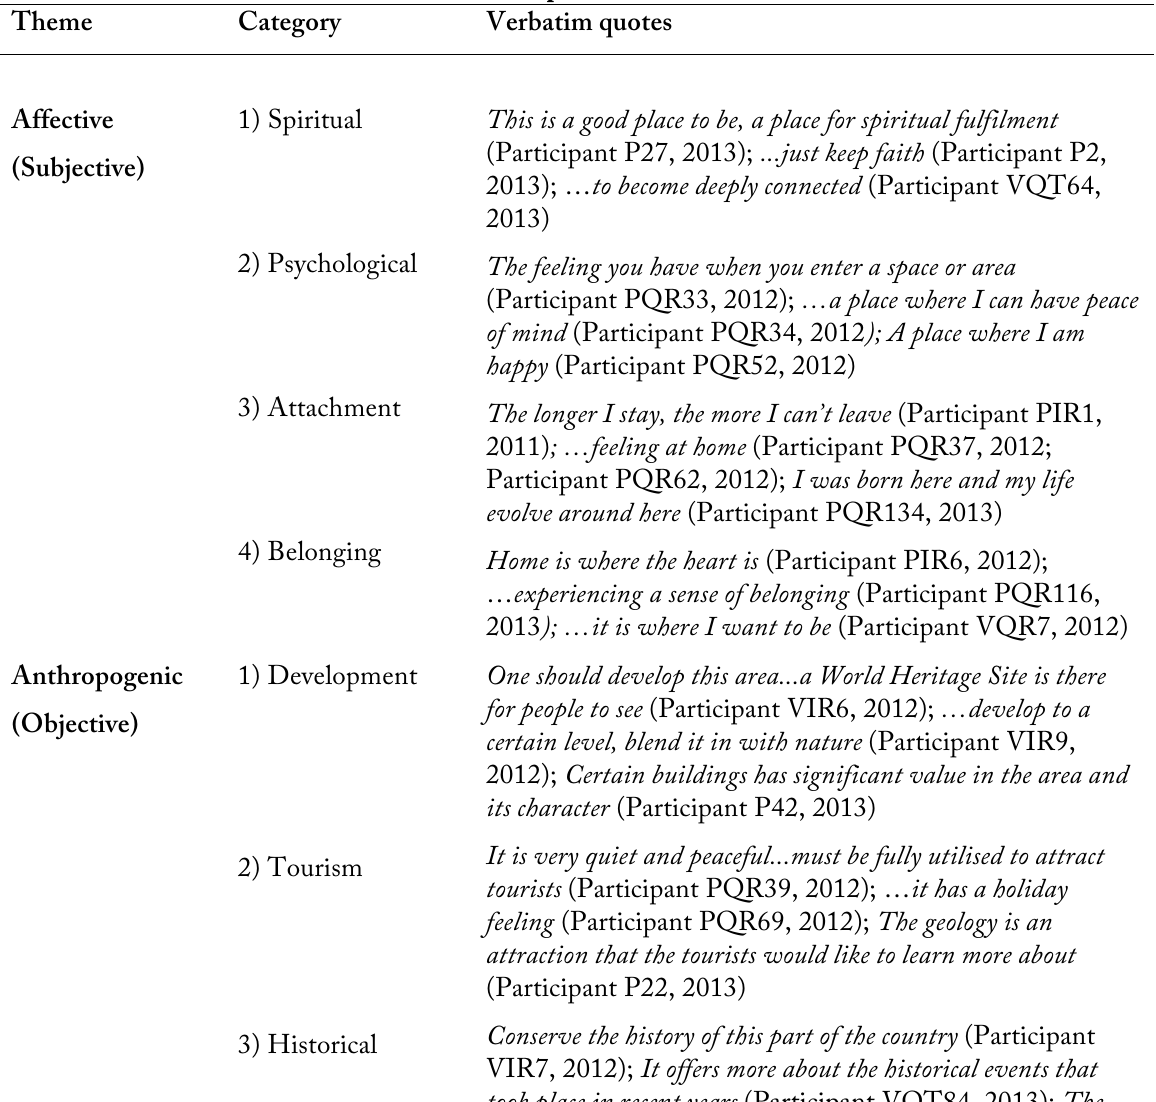
TABLE 1: Themes and categories emerging from participants’ description of the meaning of sense of